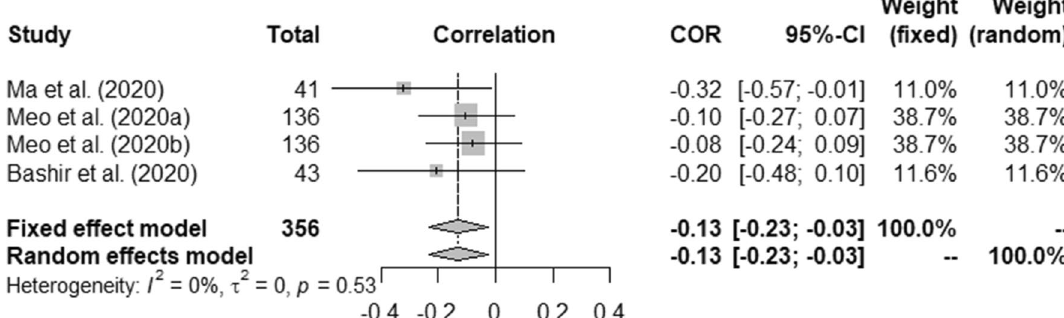
Figure 3. Forest plot of COVID-19 death rate with humidity.